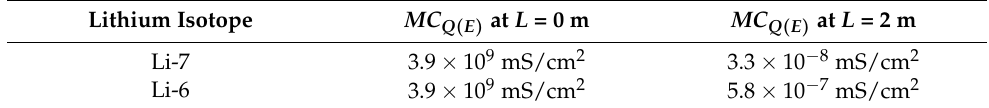
Table 12. The table shows that extracellular lithium isotopes can have a range of quantum membrane conductance from the value at L = 0 m to the value at L = 2 m according to the setting values in graph (b) of Figure 6.